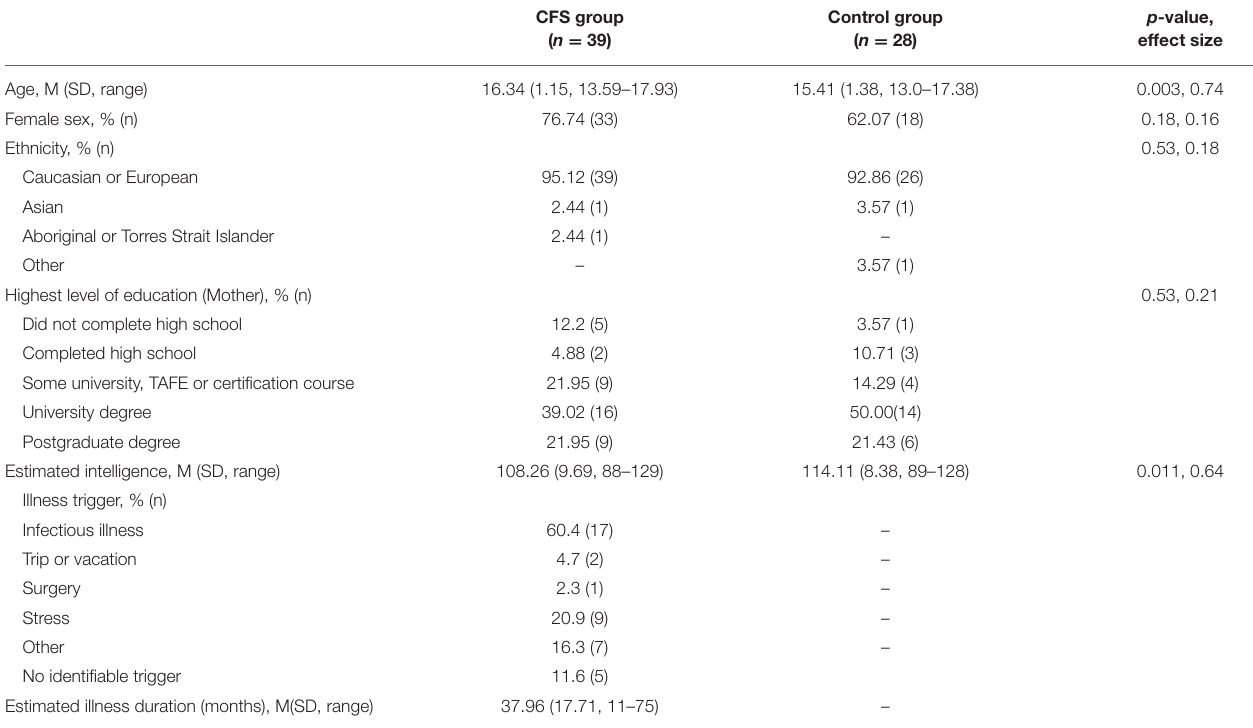
TABLE 1 | Sample characteristics.